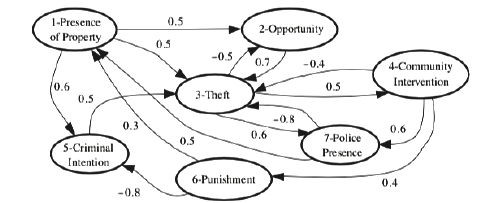
Figure 1. Example of an FCM about crime (source: Carvalho, 2013, p.